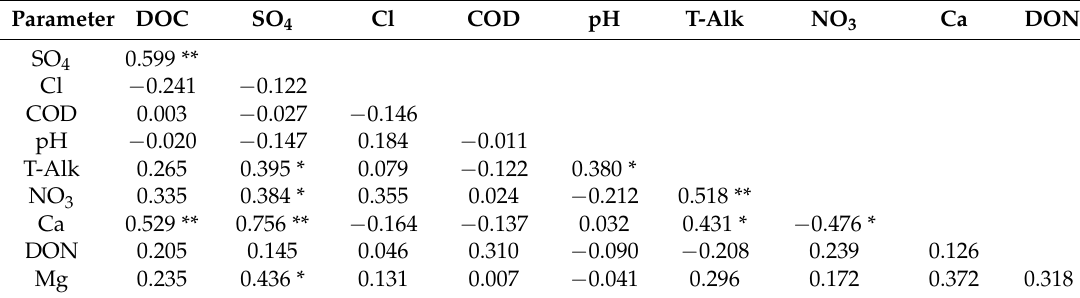
Table 5. Correlations between DOC and other constituents in Fei-Tsui Reservoir and